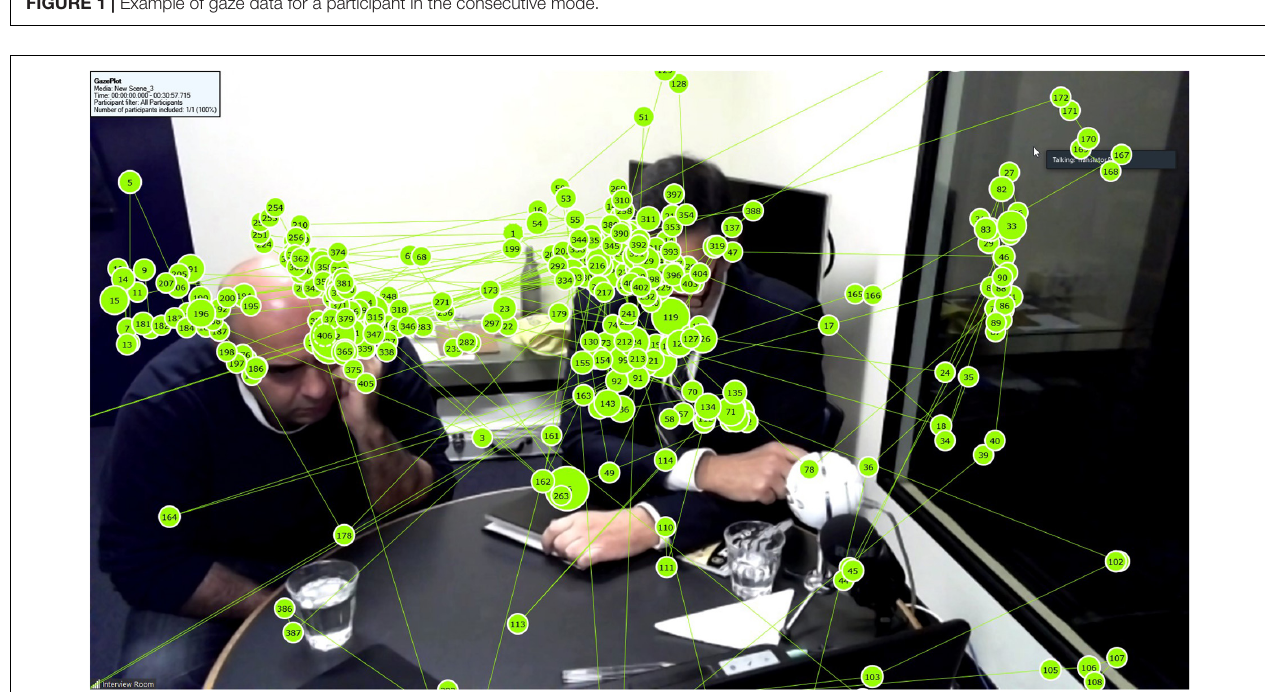
FIGURE 2 | Example of gaze data for a participant in the simultaneous